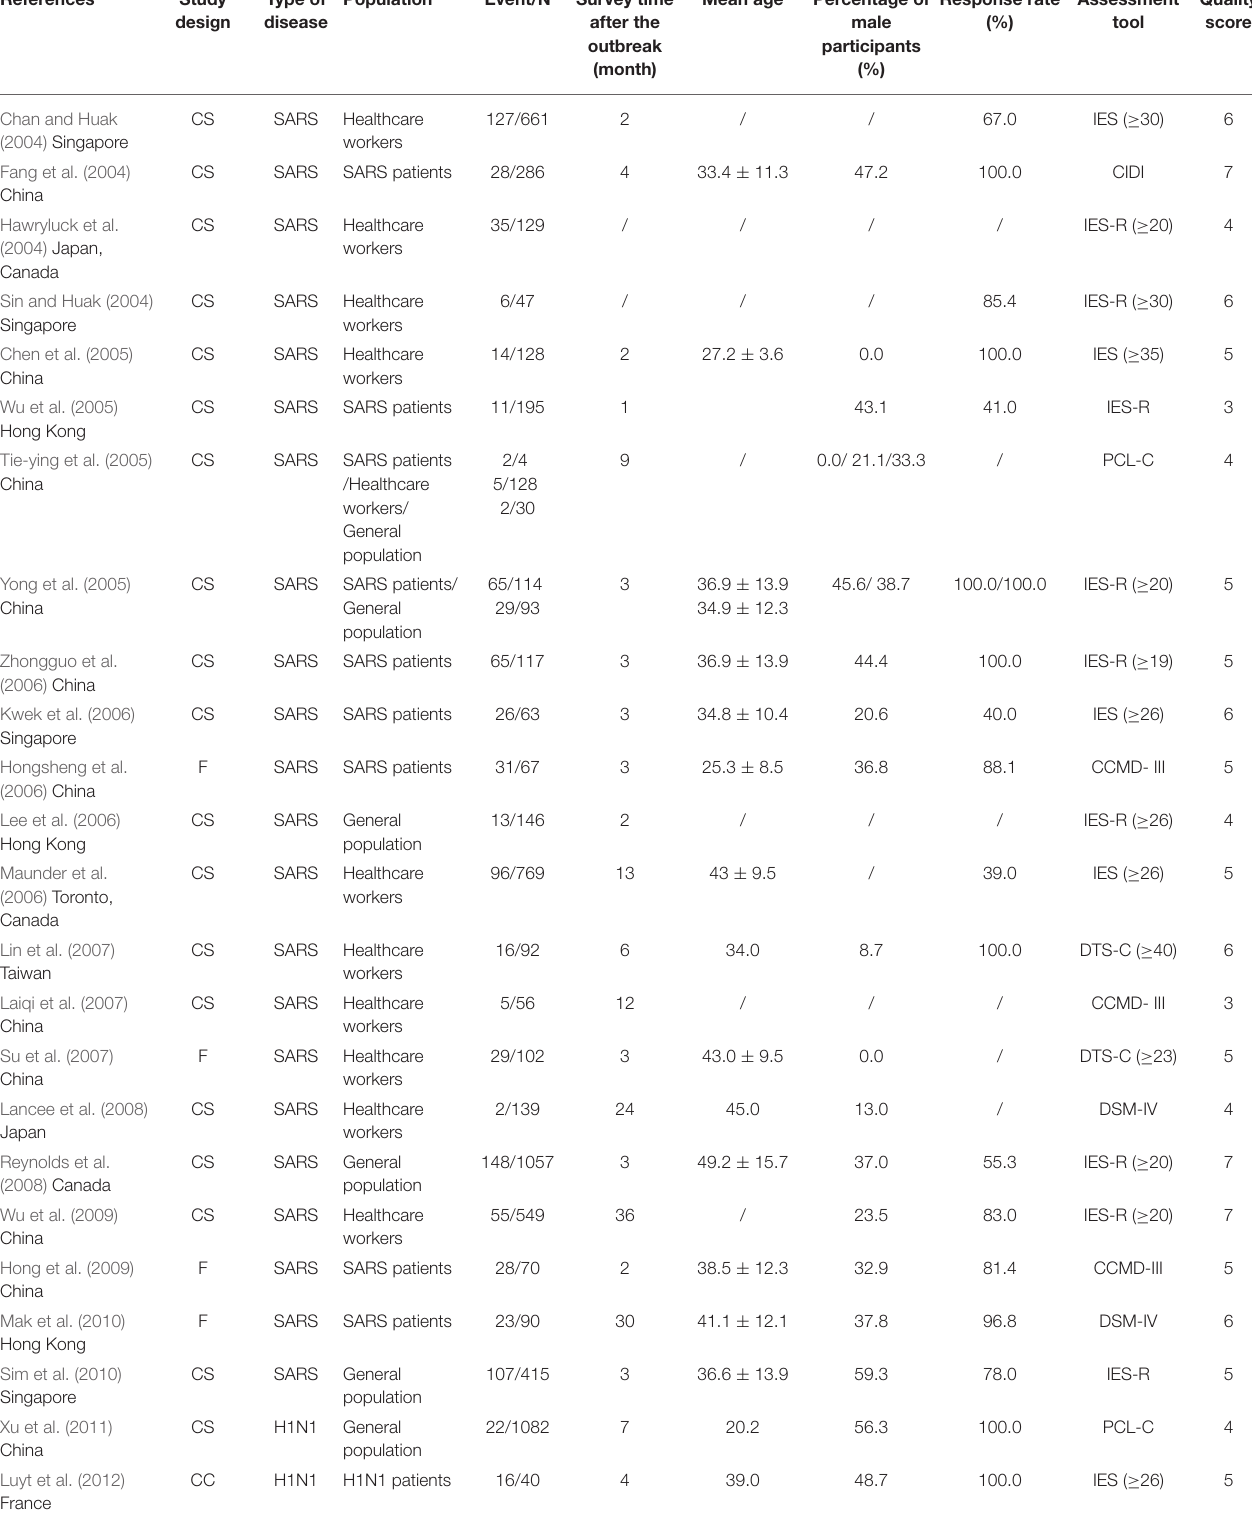
TABLE 1 | Study characteristics of the included